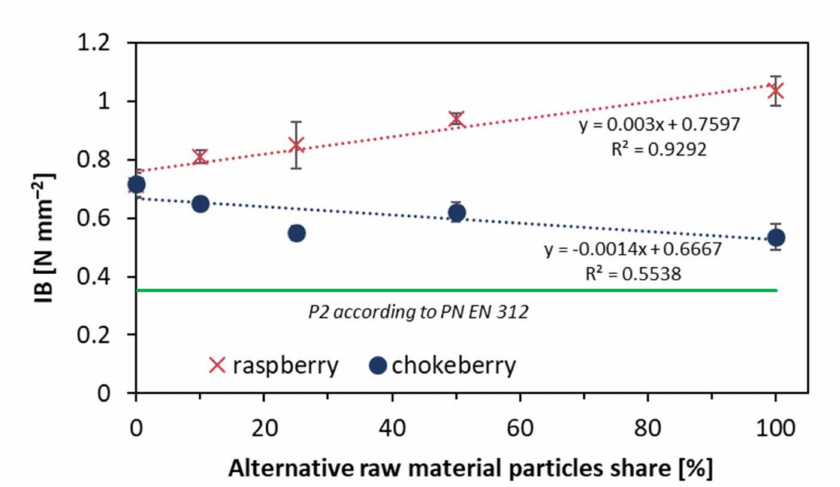
Figure 7. Internal bond of the tested composites.